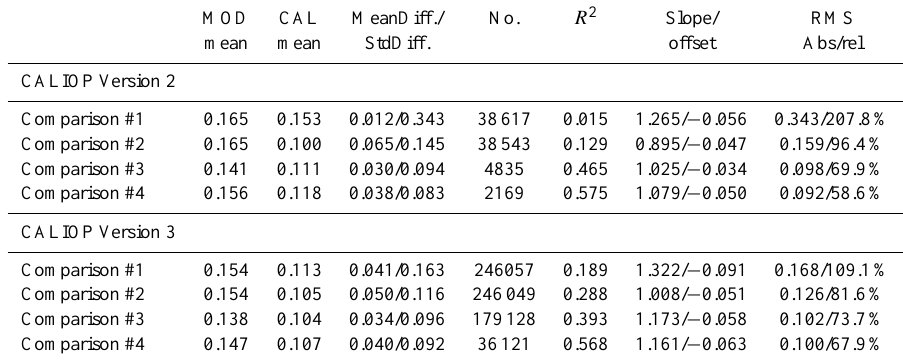
Table 7. MODIS vs. CALIOP AOD532, April 2009, over-ocean.